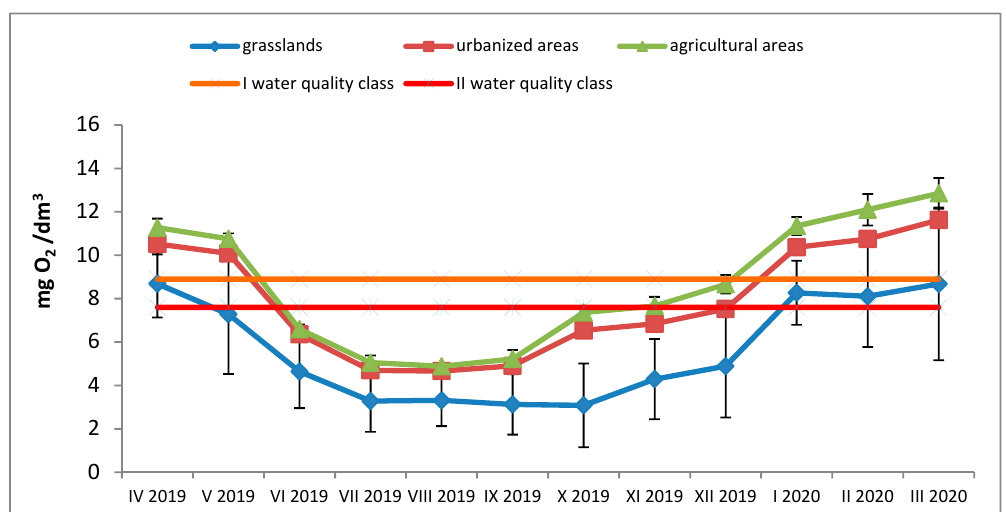
Figure 6. Mean and standard deviation for the concentration of dissolved oxygen in the water as a function of sampling date and catchment area land